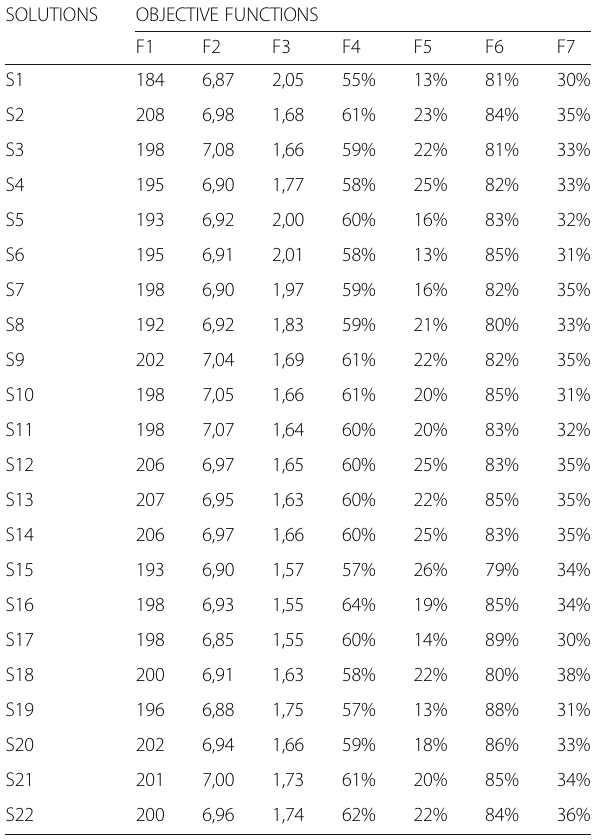
Table 2 Sample of Pareto optimal solutions proposed in the first interaction SOLUTIONS OBJECTIVE FUNCTIONS